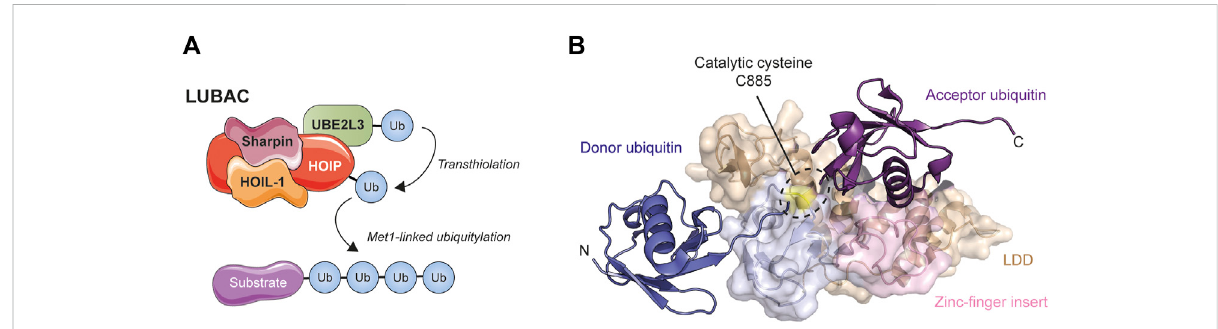
FIGURE 3 Met1-linked ubiquitin is synthesized by the Linear Ubiquitin Chain Assembly Complex (LUBAC). (A) LUBAC is a trimeric complex composed of HOIP, HOIL-1, and Sharpin. HOIPbinds its cognate E2(very likely UBE2L3 (Lewiset al.,2015))and by meansof atransthiolationmechanismthat sees ubiquitintransferredtoCys885inthecatalyticRBRdomainoftheligase,buildsMet1-linked( ‘ linear ’ )ubiquitinchainsinwhichpeptidebondsbetween theC-andN-terminiofubiquitincreateasinglecontinuouspolypeptidechainofrepeatingubiquitinunits. (B) Structureoftheminimalcatalytic coreofHOIPincomplexwithacceptor(purple)anddonor(darkblue)ubiquitin(PDB:4LJO)(Stieglitzetal.,2013).TheuniqueLDD(wheatcolour)and zinc- fi nger (pink) domains of HOIP help ensure that the C-terminus of the donor ubiquitin and N-terminus of the acceptor ubiquitin align for Met1 linkage formation. Note the proximity of the catalytic cysteine (coloured yellow) to the N-terminus of the acceptor ubiquitin, explaining the speci fi city for linear